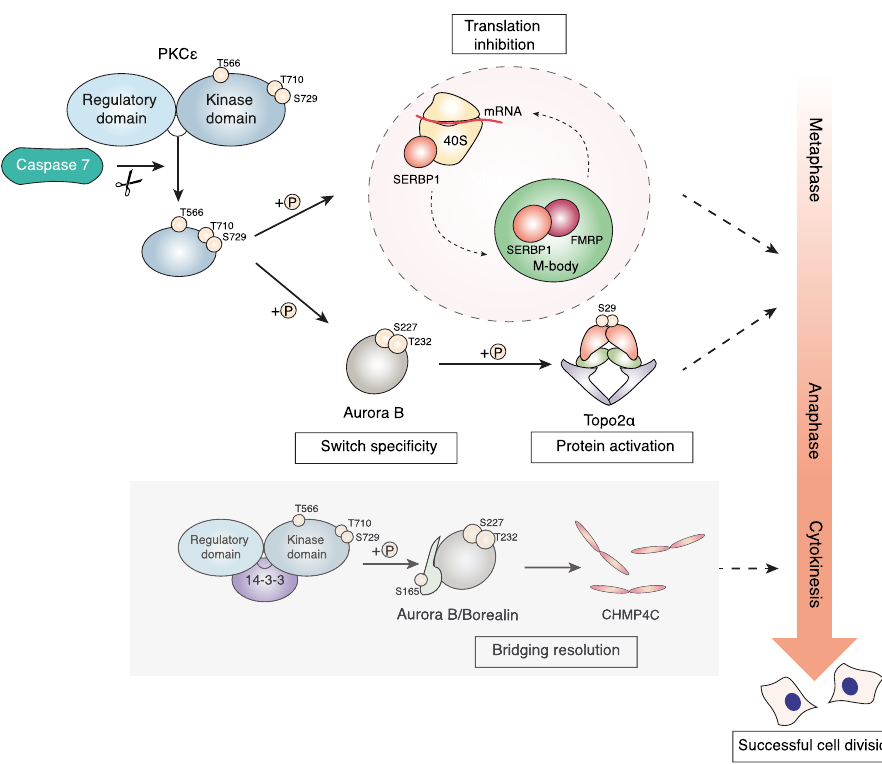
Fig. 8 Schematic showing the multiple pathways regulated by PKC ε engaged at several steps of mitosis in order to ensure successful cell division. Prior to anaphase, a pool of constitutively active PKC ε generated by Caspase 7 acts through Aurora B and Topoisomerase 2 α phosphorylation, as previously decribed 4 , or through protein translation repression in fl uencing SERBP1 positioning on the 40S subunit of the ribosome and SERBP1/FMRP M-body formation. Later in cytokinesis, 14-3-3/PKC ε complex formation is required for Aurora B phosphorylation and the exit from the abscission checkpoint 48